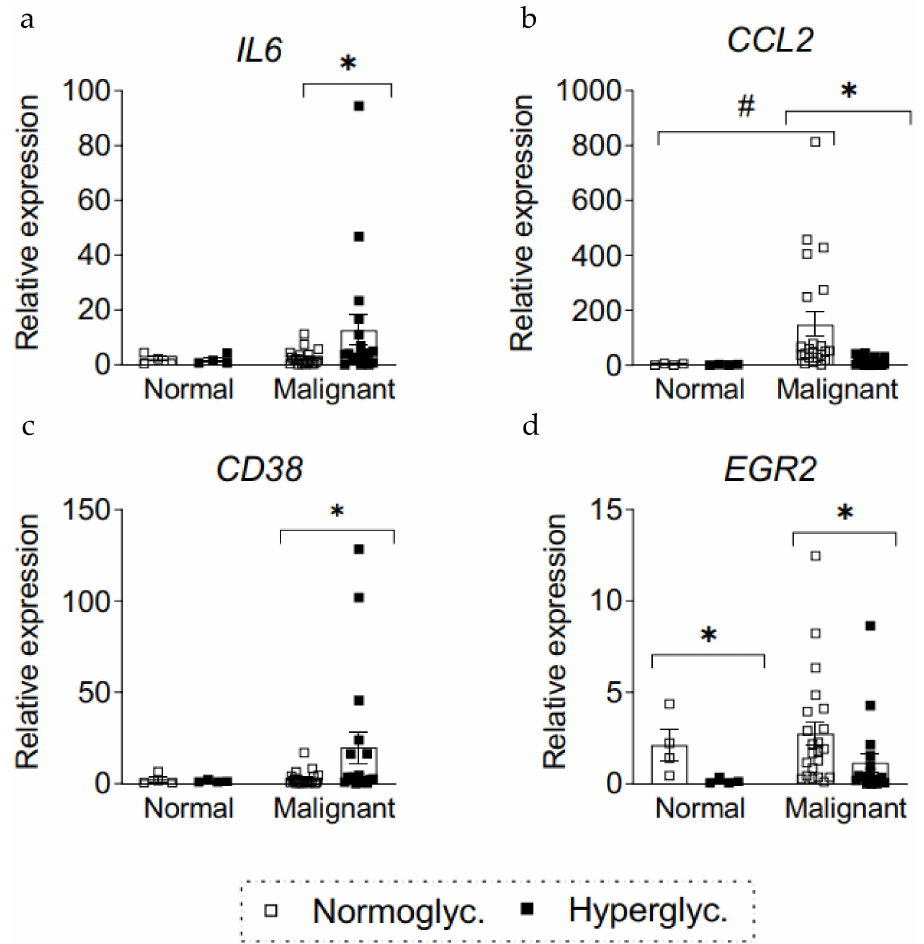
Figure 4. Expression of inflammatory markers in BC tumors from hyperglycemic patients. RNA from whole tumors were extracted and assayed for pro-inflammatory markers (Il6, ( a ); and Ccl2, ( b ) and macrophage markers (Cd38, c ; and Egr2, d ) in chronically hyperglycemic or normoglycemic patients. Normal tissue is non-malignant adjacent tissue. Data are normalized to 5S. Bars represent the mean ± SEM. * p < 0.05 comparing to normoglycemic controls, # p < 0.05 comparing to normal